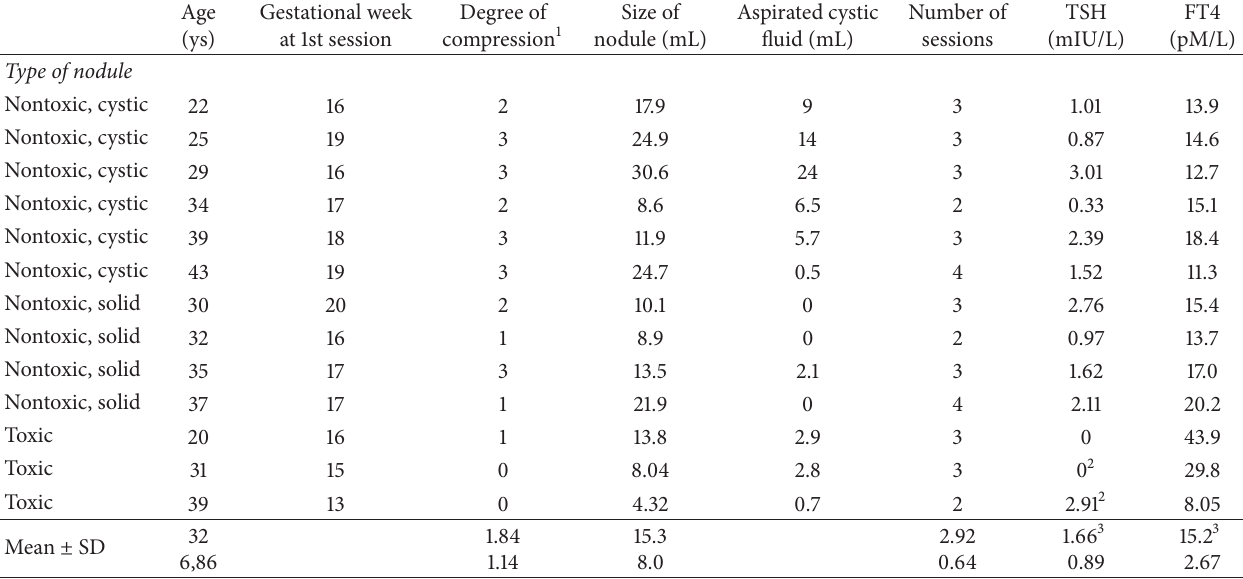
Table 1: Pretreatment clinical data on